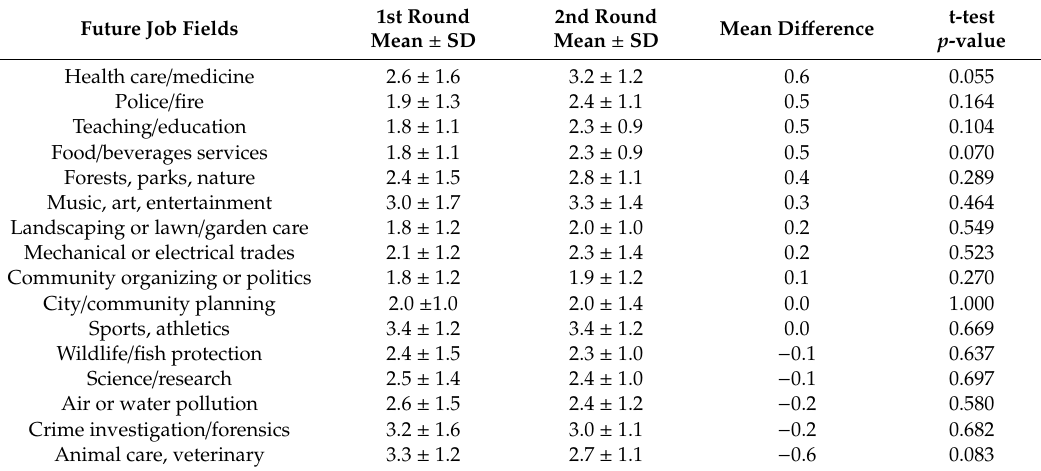
Table 6. Participants’ levels of interest in future jobs fields (paired pre-post surveys; n =